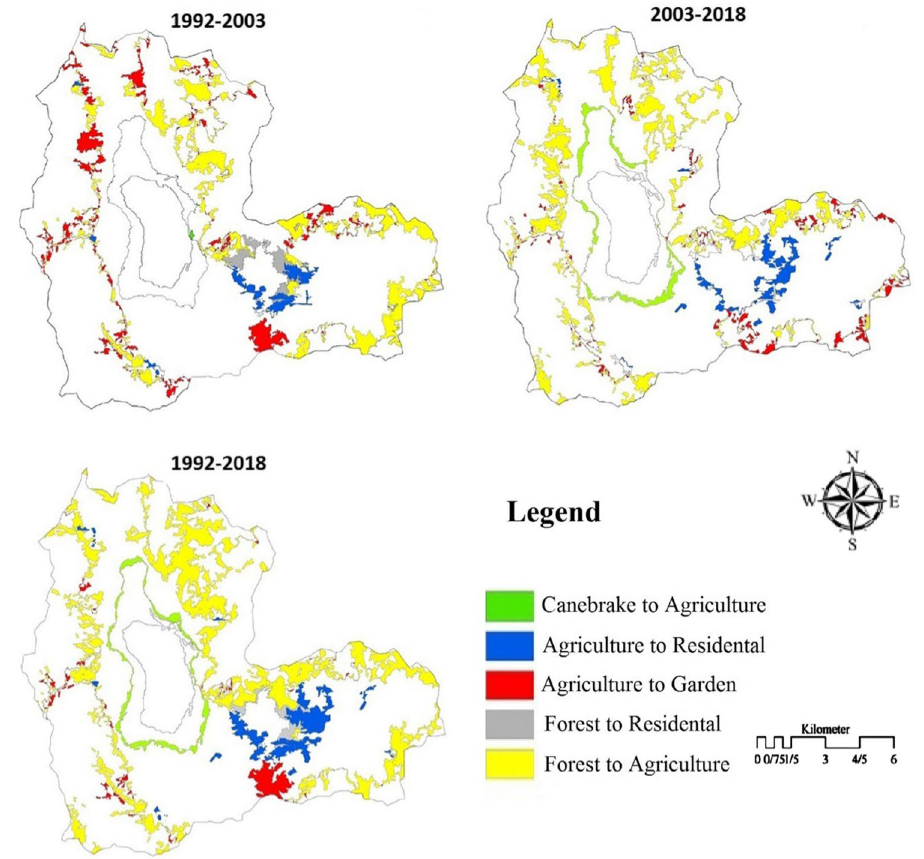
Fig. 4 The areas which changed in terms of